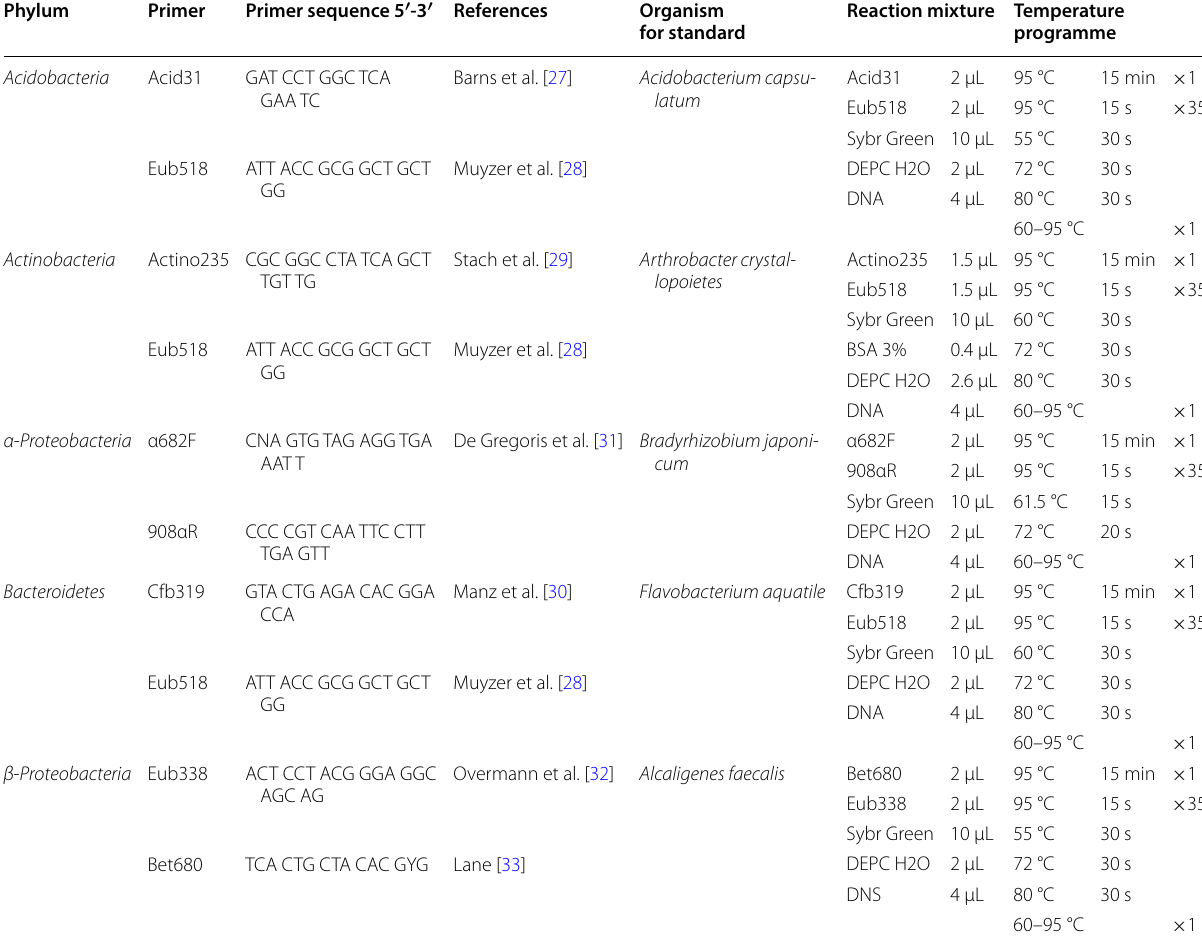
Table 1 PCR primers and cycling conditions used for quantification of the different phyla